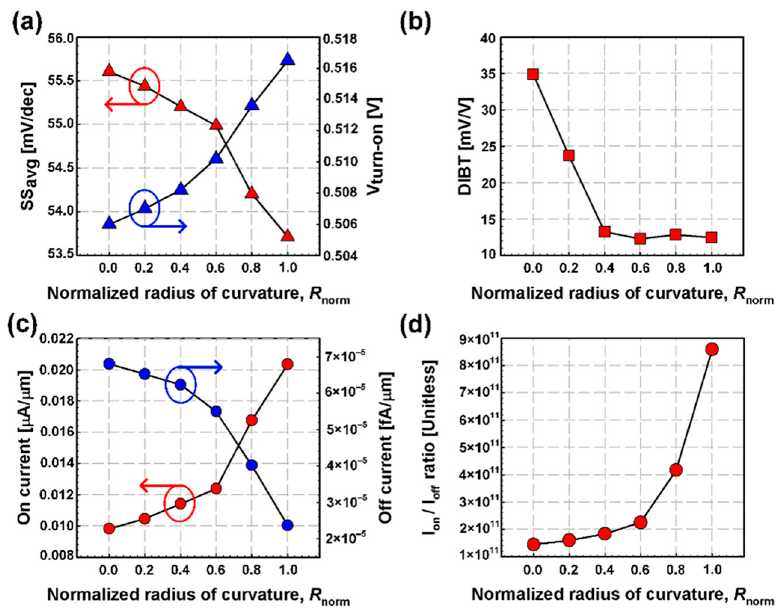
Figure 11. ( a ) SS avg and V turn-on , ( b ) DIBT , ( c ) I on and I off and ( d ) I on / I off ratio as a function of R norm .